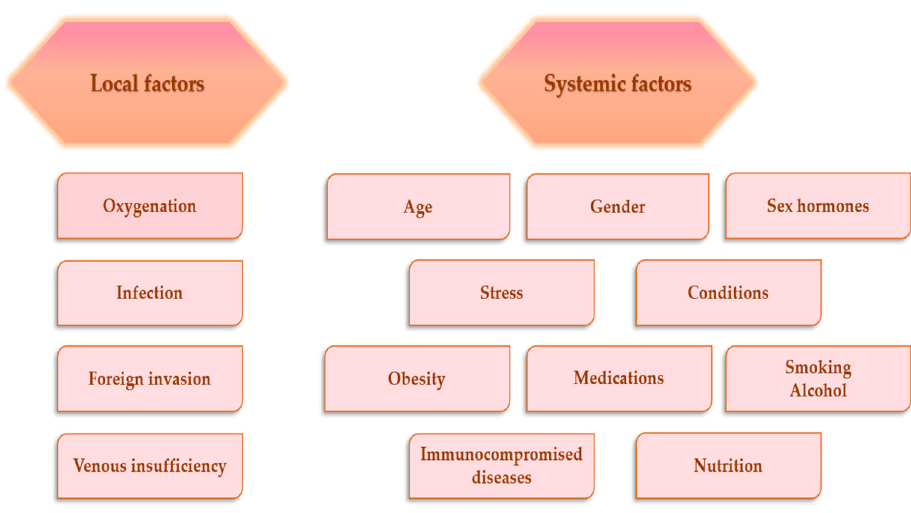
Figure 2. Factors affecting wound-healing process [57,58].